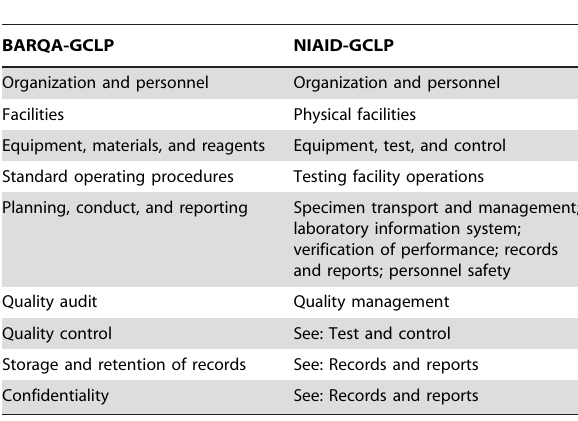
Table 1. BARQA-GCLP and NIAID-GCLP core elements.